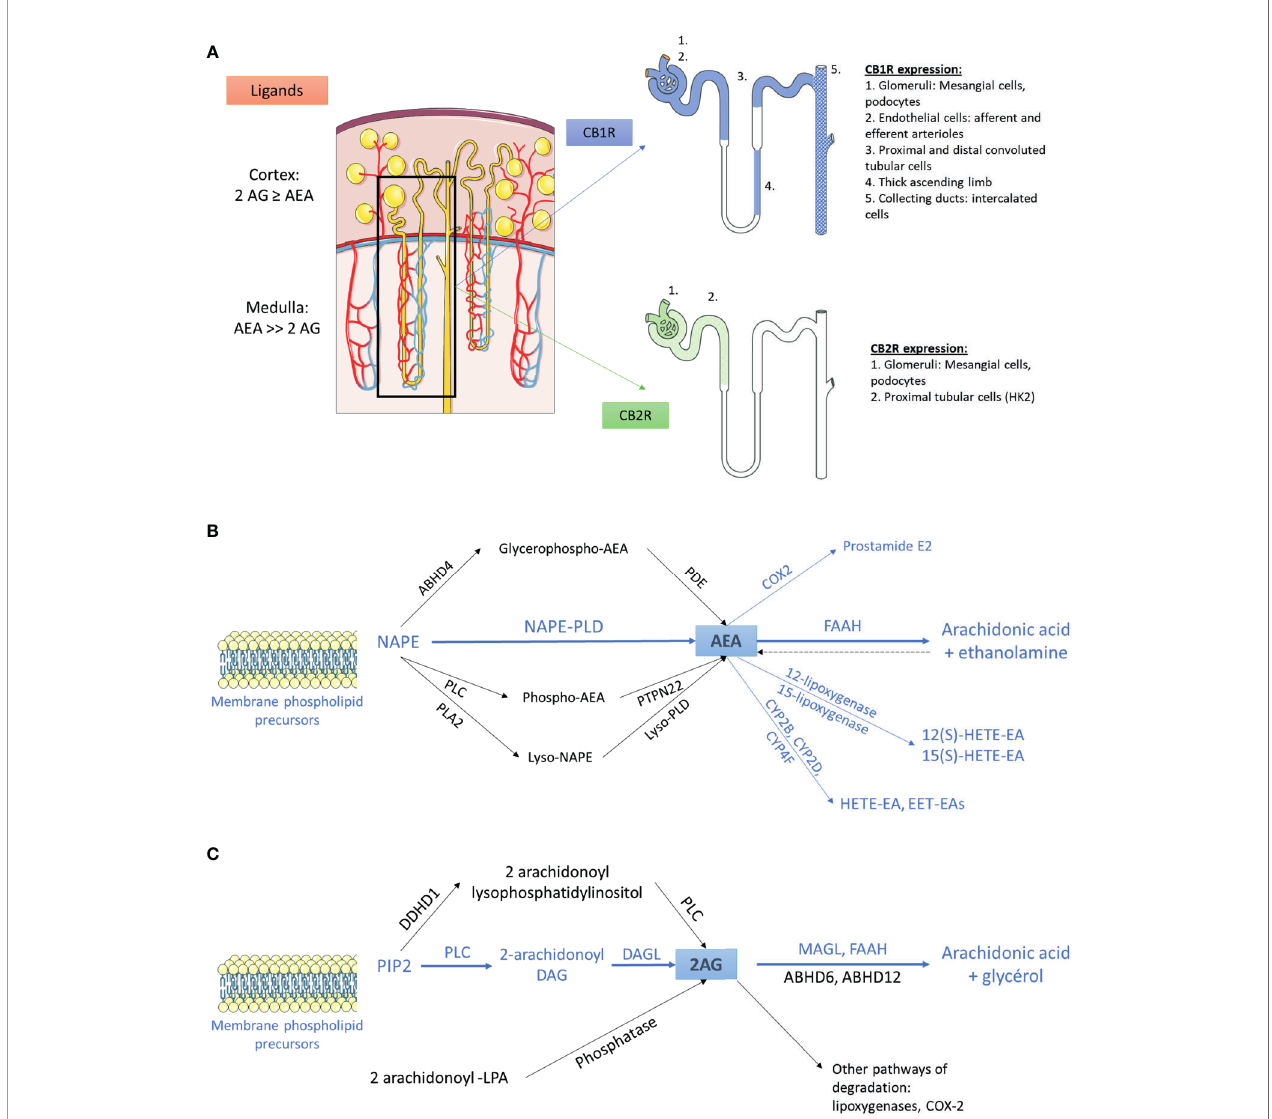
FIGURE 1 | The endocannabinoid system within the kidney (A) Distribution of main endogenous ligands and cannabinoid receptors in healthy kidneys. (B) Biosynthesis and degradation of anandamide. The pathways that were demonstrated within the kidney are in blue. The other pathways are in black. (C) Biosynthesis and degradation of 2-arachidonoyl-glycerol. The pathways that were demonstrated within the kidney are in blue. The other pathways are in black. 2AG, 2-arachidonoyl-glycerol; ABHD, a / b -Hydrolase domain containing; AEA, anandamide; CB1R, cannabinoid receptor type 1; CB2R, cannabinoid receptor type 2; COX2, cyclooxygenase 2; CYP, cytochrome P450; DAG, diacylglycerol; DAGL, sn -1-speci fi c diacylglycerol lipase; DDHD1, phosphatidic acid-preferring phospholipase A1; EET-EA, epoxyeicosatrienoic acid-ethanolamine; FAAH, fatty acyl amide hydrolase; HETE-EA, hydroxyeicosatetraenoic acid-ethanolamine; LPA, lysophosphatidic acid; MAGL, monoacylglycerol lipase; NAPE, N-arachidonoyl phosphatidyl ethanolamine; PDE, phosphodiesterase; PIP2, 2-arachidonoyl- phosphatidylinositol 4,5-bisphosphate; PLA2, phospholipase A2; PLC, phospholipase C; PLD, phospholipase